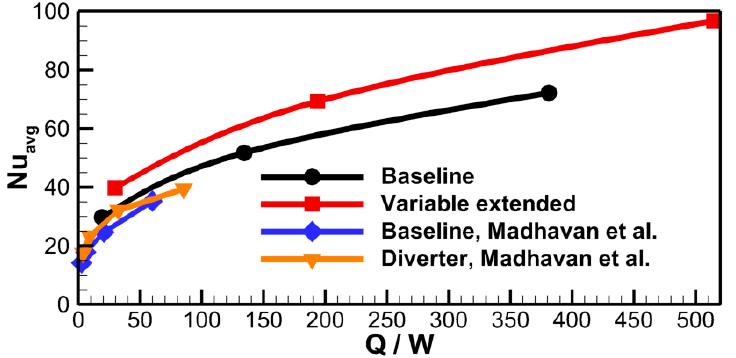
Figure 18. Area-averaged Nu as a function of pumping power for the baseline and variable extended cases, along with the data for the configurations ( x n / d = y n / d = 6, z / d = 2) from Madhavan et al. [30].